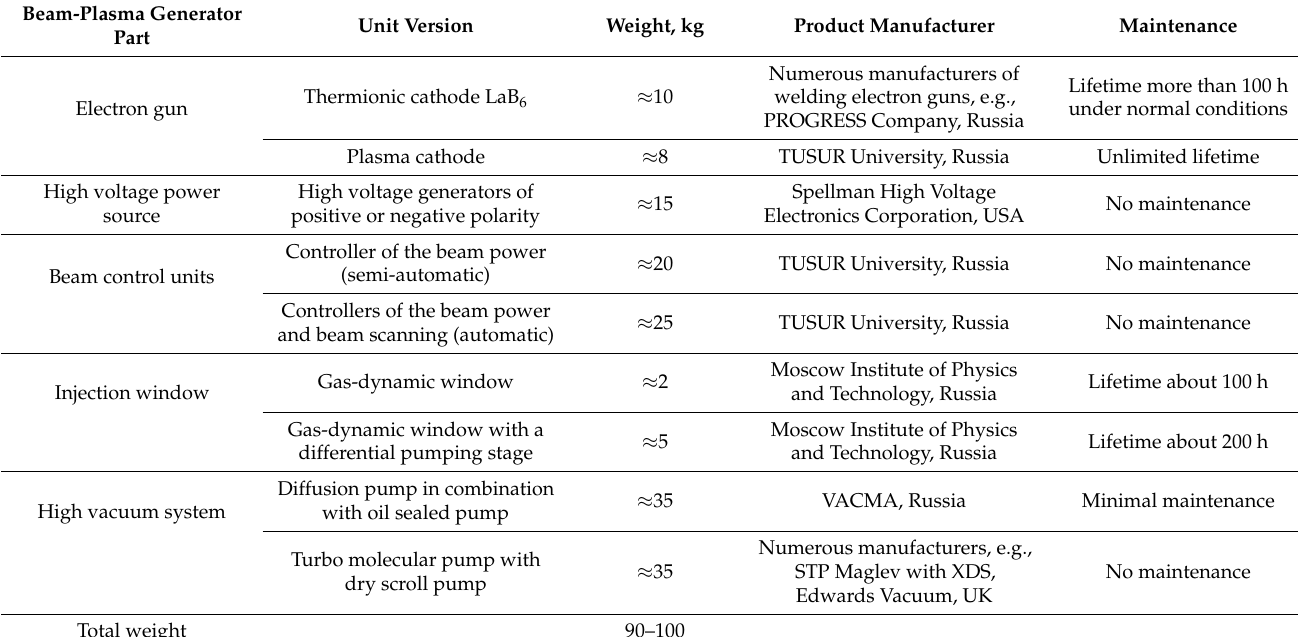
Table A1. The availability and the maintenance of